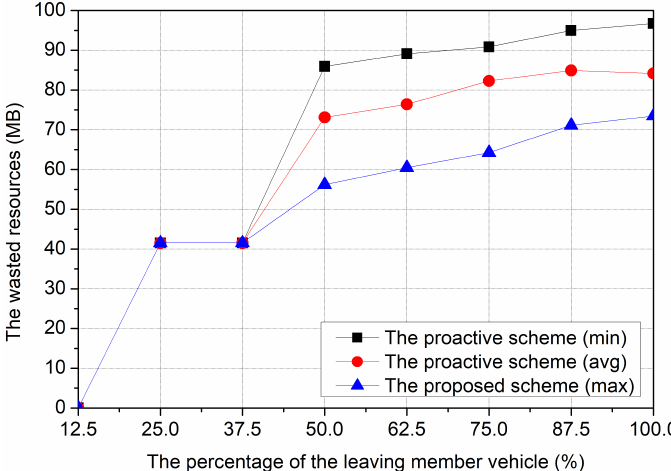
Figure 8. The wasted resources for the percentage of the leaving member